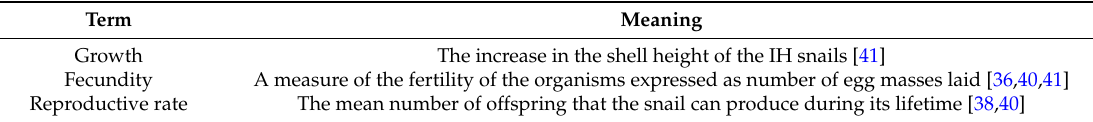
Table 2. Some important terms that have been used in the